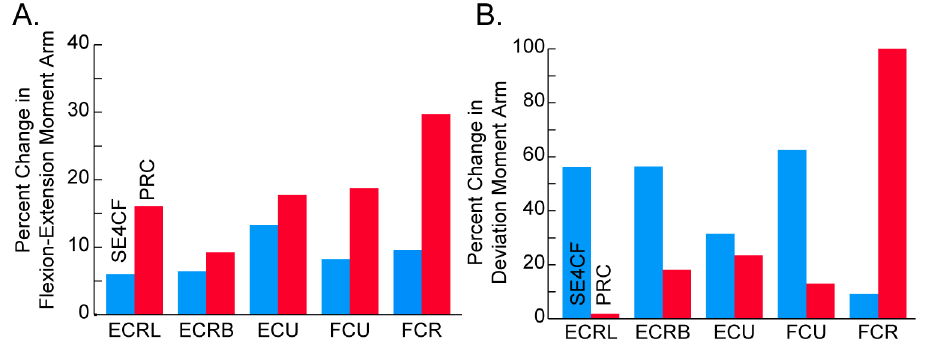
relative to the nonimpaired model. Note that the y-axis scales are different between the two panels.